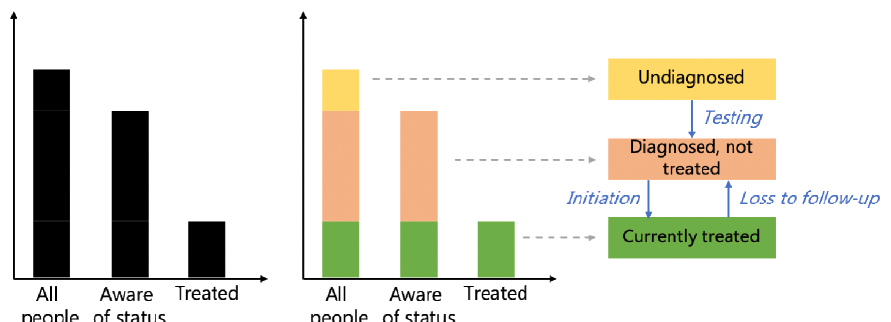
Figure 4. A generic treatment cascade (panel A), which is translated (panel B) into a compartmental model (panel